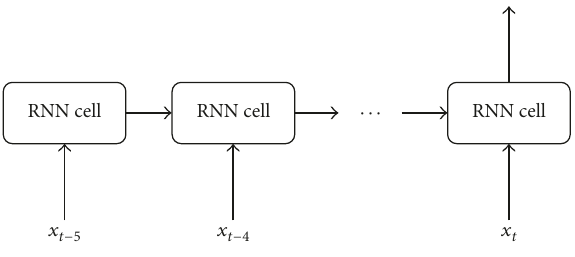
Figure 3: RNN unfolded into a full